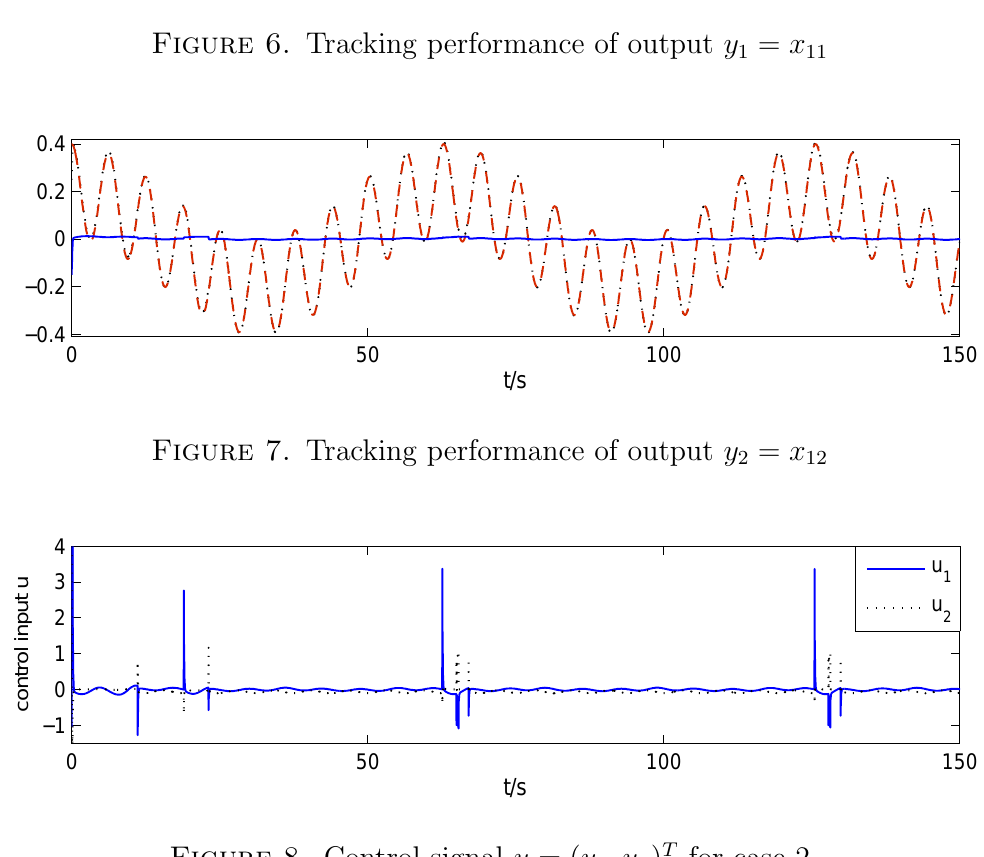
; u ) T for case 1 2